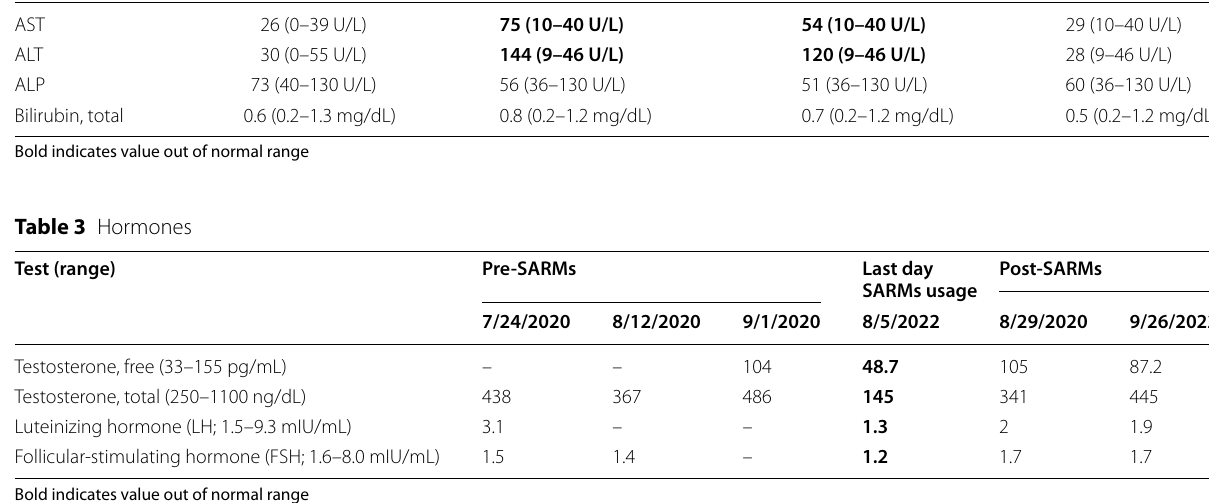
Bold indicates value out of normal range